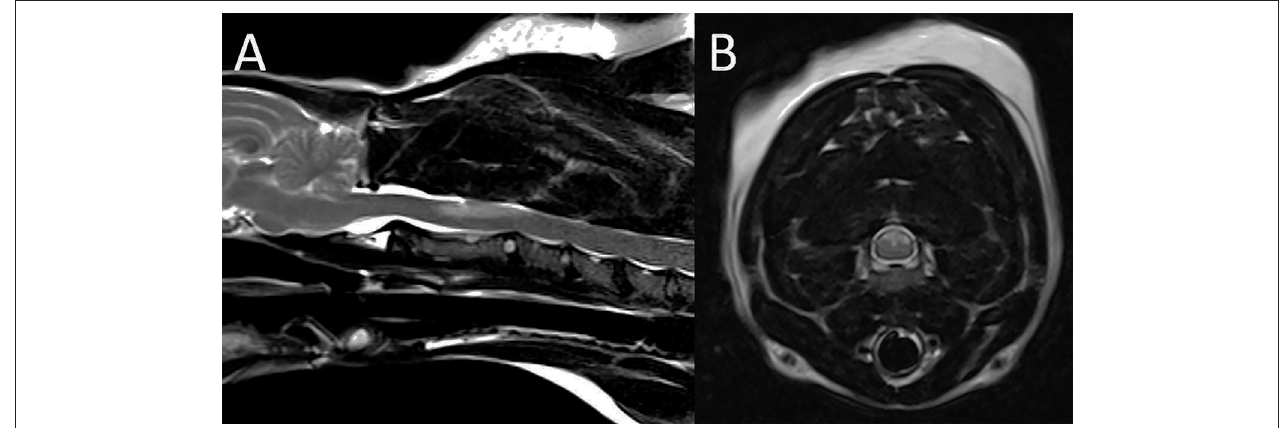
FIGURE 11 | Suspected ischemic event in a leopard. On sagittal (A) and transverse (B) T2 weighted images there is a T2 moderately hyperintense intramedullary lesion within the dorsal aspect of the spinal cord at the level of C2 which appears symmetric and wedge-shaped on the transverse image. Note also multifocal degenerative intervertebral disc disease.